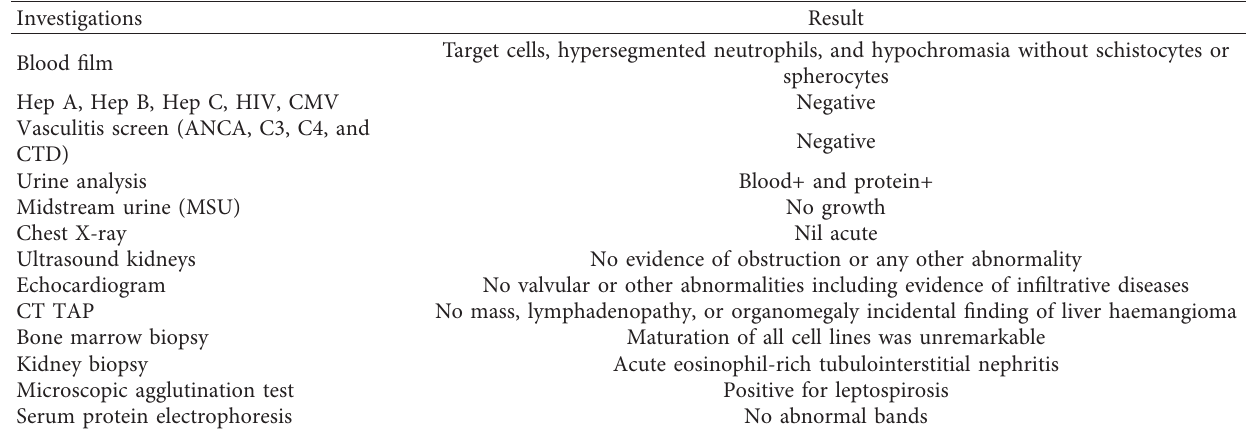
Figure 2: (a) Hematoxylin and eosin staining (H&E) ∗ with 400 magnification. The image shows tubulointerstitial inflammation with lymphocytes, plasma cells, and some eosinophils (single arrow) interstitial oedema with wide spacing of the tubule (double arrow). (b) Periodic acid Schiff (PAS) ∗ with 600 magnification. The image shows moderate tubulitis with lymphocytes in the wall of the tubule (single arrow) and tubule destruction (double arrow) with fragmented tubular basement membrane. Table 2: Investigation results.